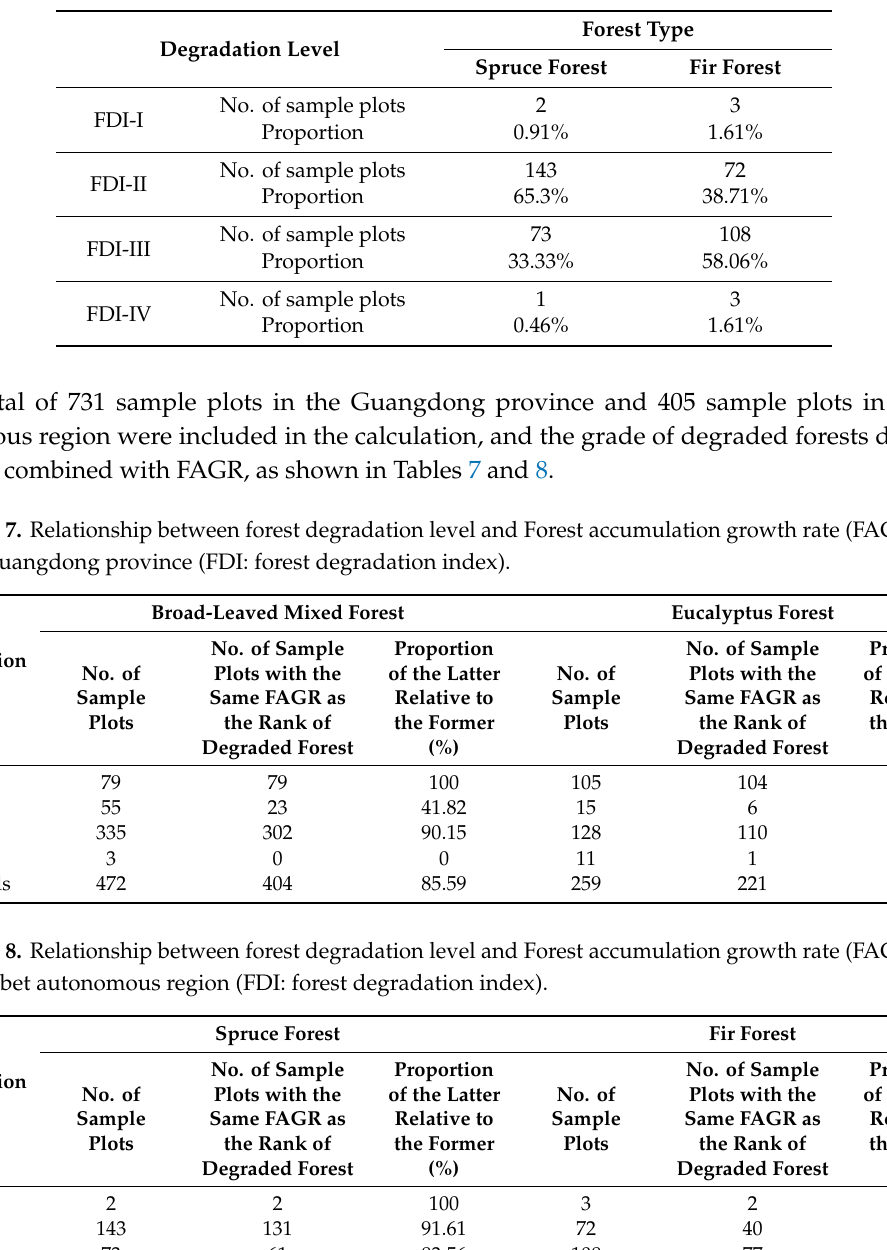
Table 6. Evaluation results of forest degradation grade of two forest types divided by dominant tree species in the Tibet autonomous region. A total of 405 sample plots of the region were included in the study. FDI: forest degradation index.